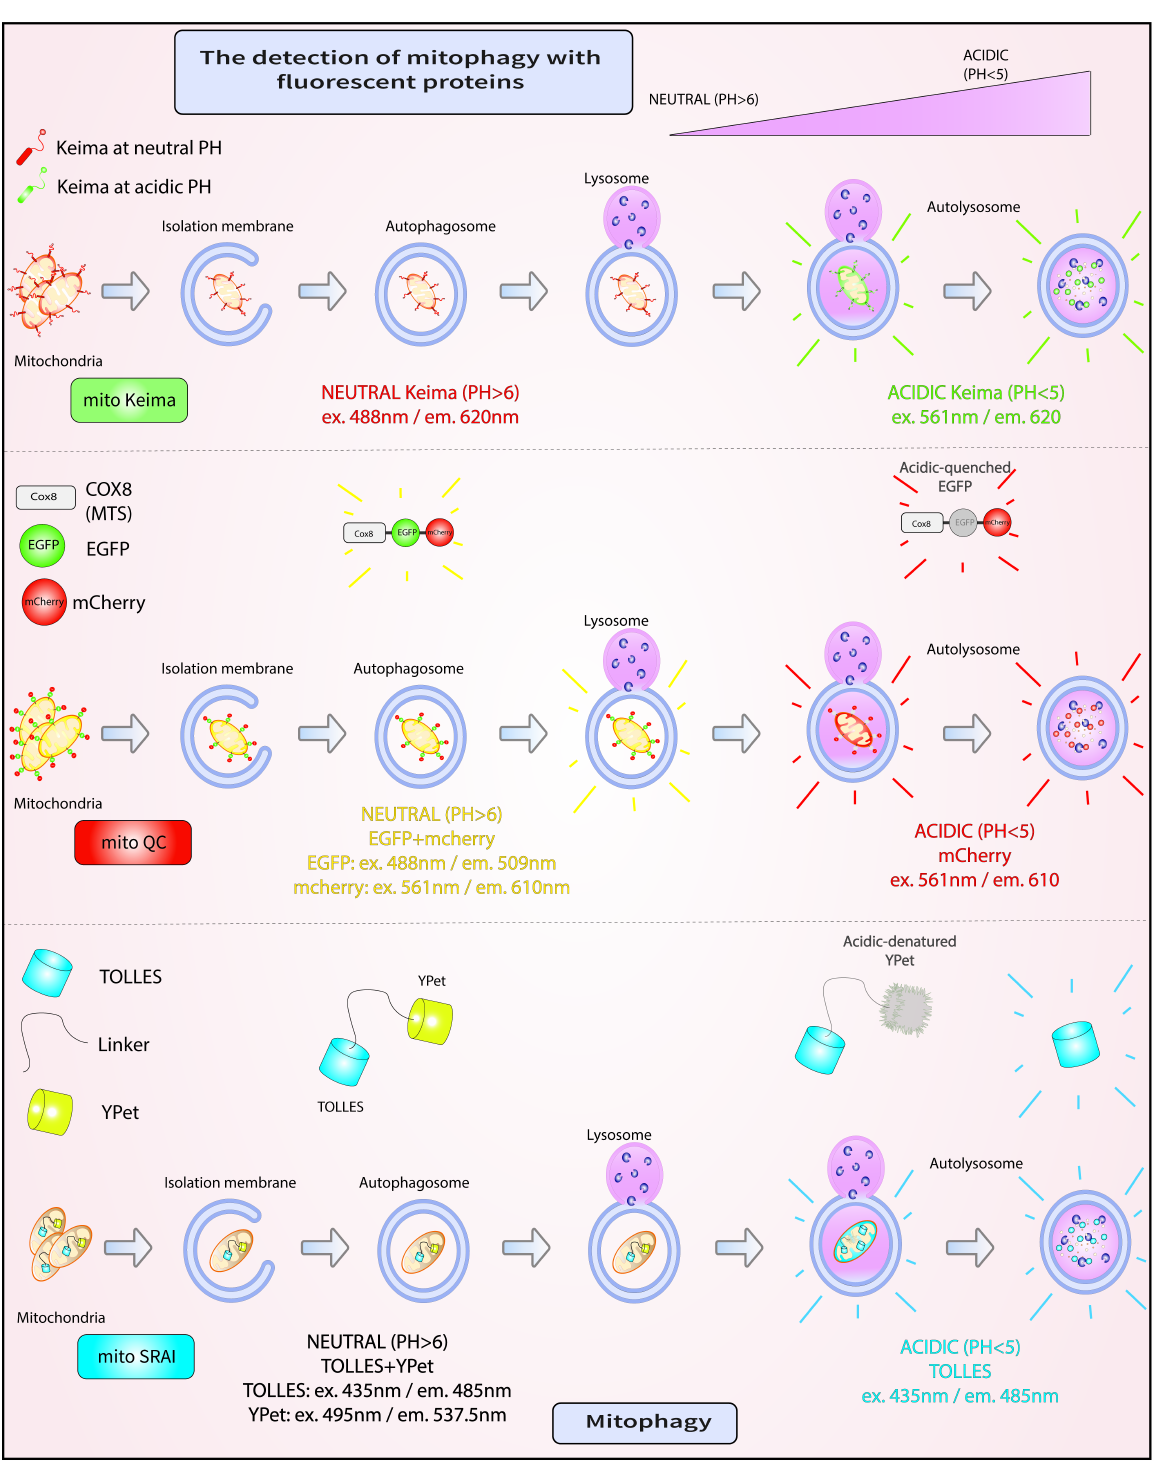
Figure 3. Fluorescent assays for mitophagy. A. mito-Keima is a pH-sensitive fluorescent biosensor, which fluoresces green at neutral pH in the cytosol, and red upon entry into acidic autolysosomes. B. mito-QC comprises two mitochondrially-targeted tandem fluorescent proteins, EGFP and mCherry. Both EGFP and mCherry fluoresce in the cytosol. However, in the lysosome, the fluorescence of mCherry is retained, while that of GFP is lost. C. mito-SRAI consists of two mitochondrially-targeted tandem fluorescent proteins, TOLLES and YPet. Unlike YPet, which is pH sensitive, TOLLES evades both acid-denaturation and proteolysis inside the lysosomal lumen and retains